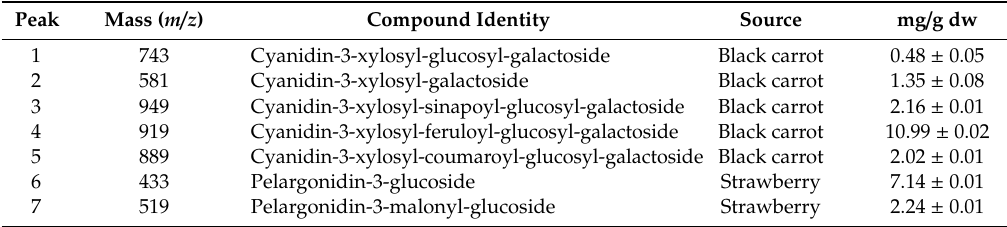
Table 1. Identification and quantification of black carrot and strawberry anthocyanins. Peak Mass ( m / z ) Compound Identity Source mg / g dw